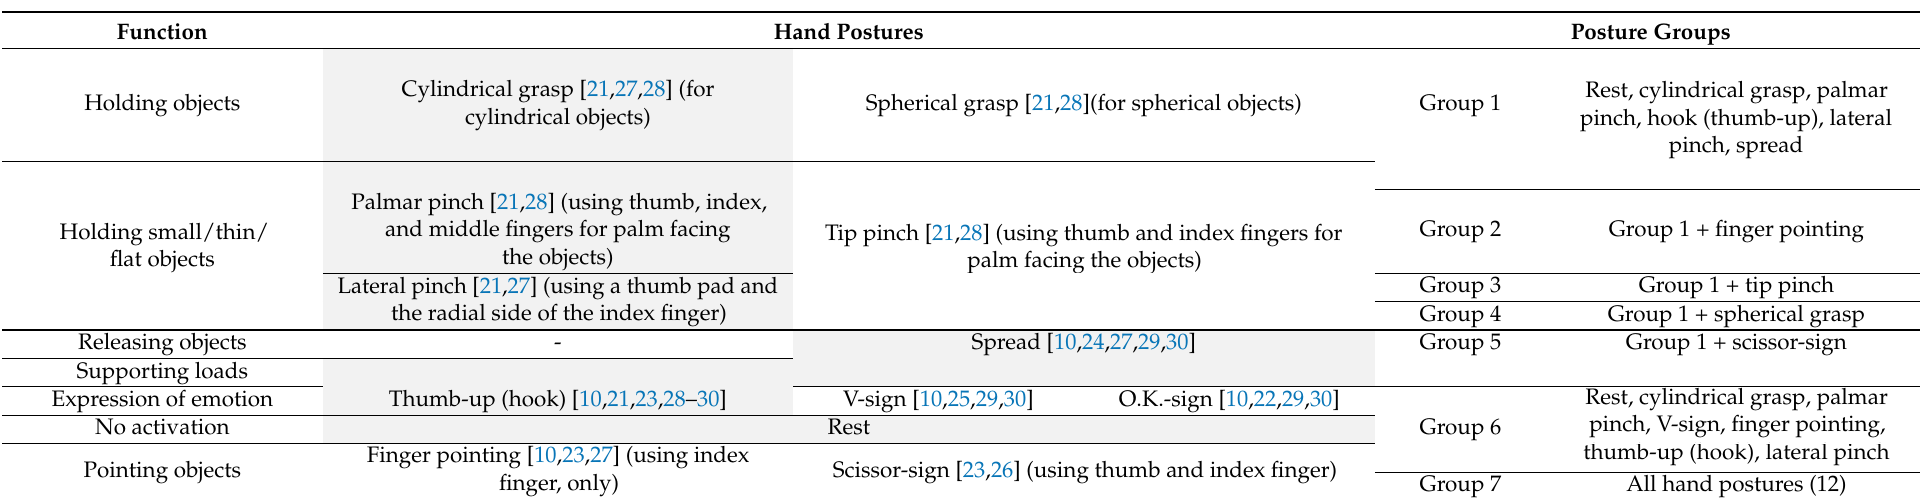
Table 1. Hand posture functions and